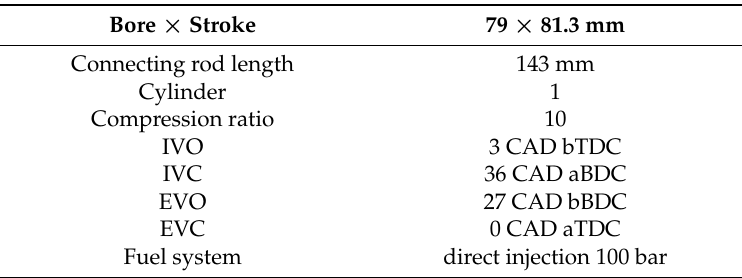
Figure 1. Experimental setup and detail of the optical path for digital imaging. Table 1. Engine specifications.